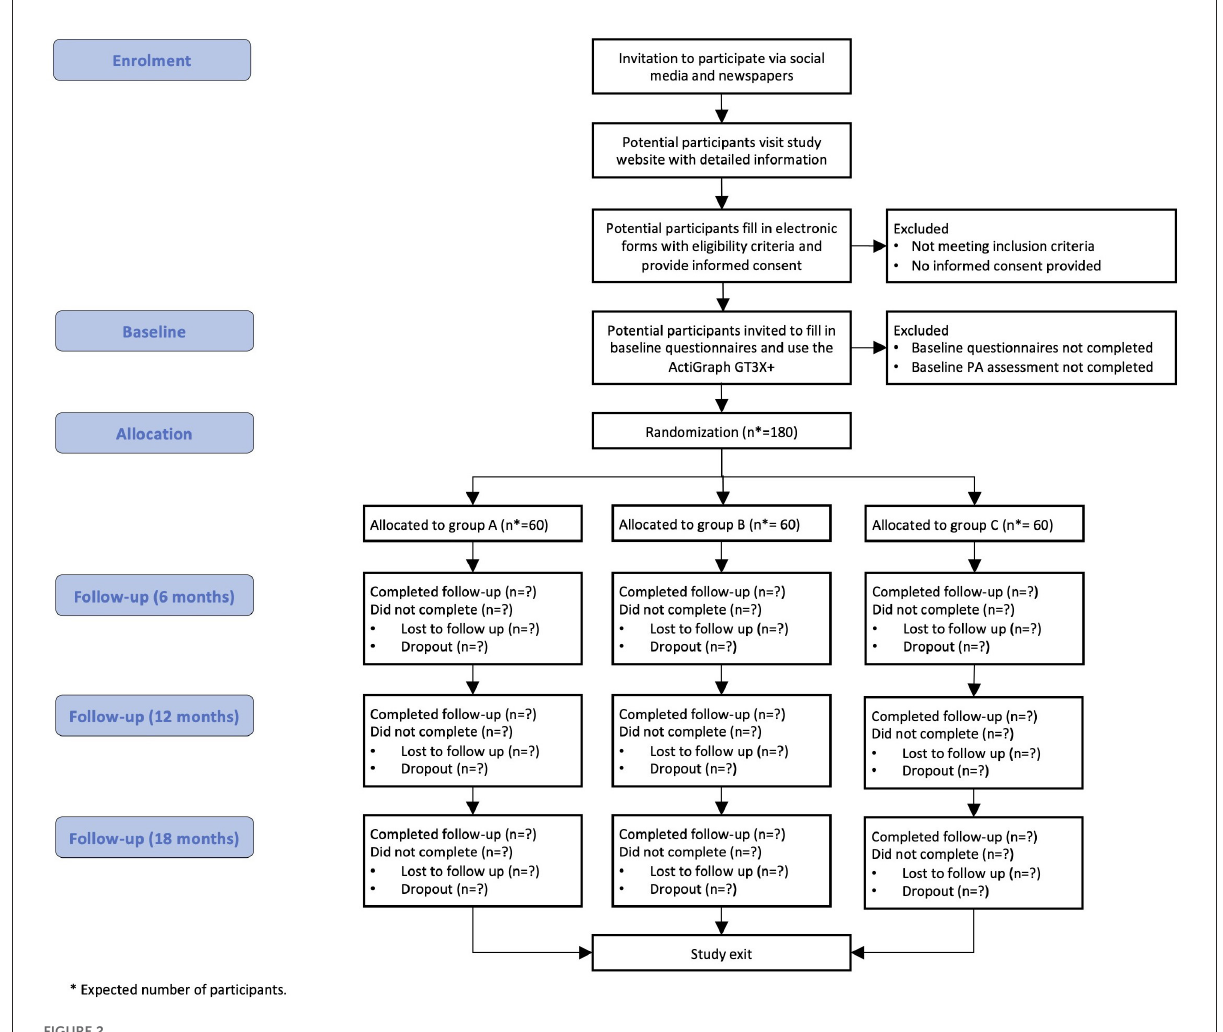
FIGURE2 Flow of study